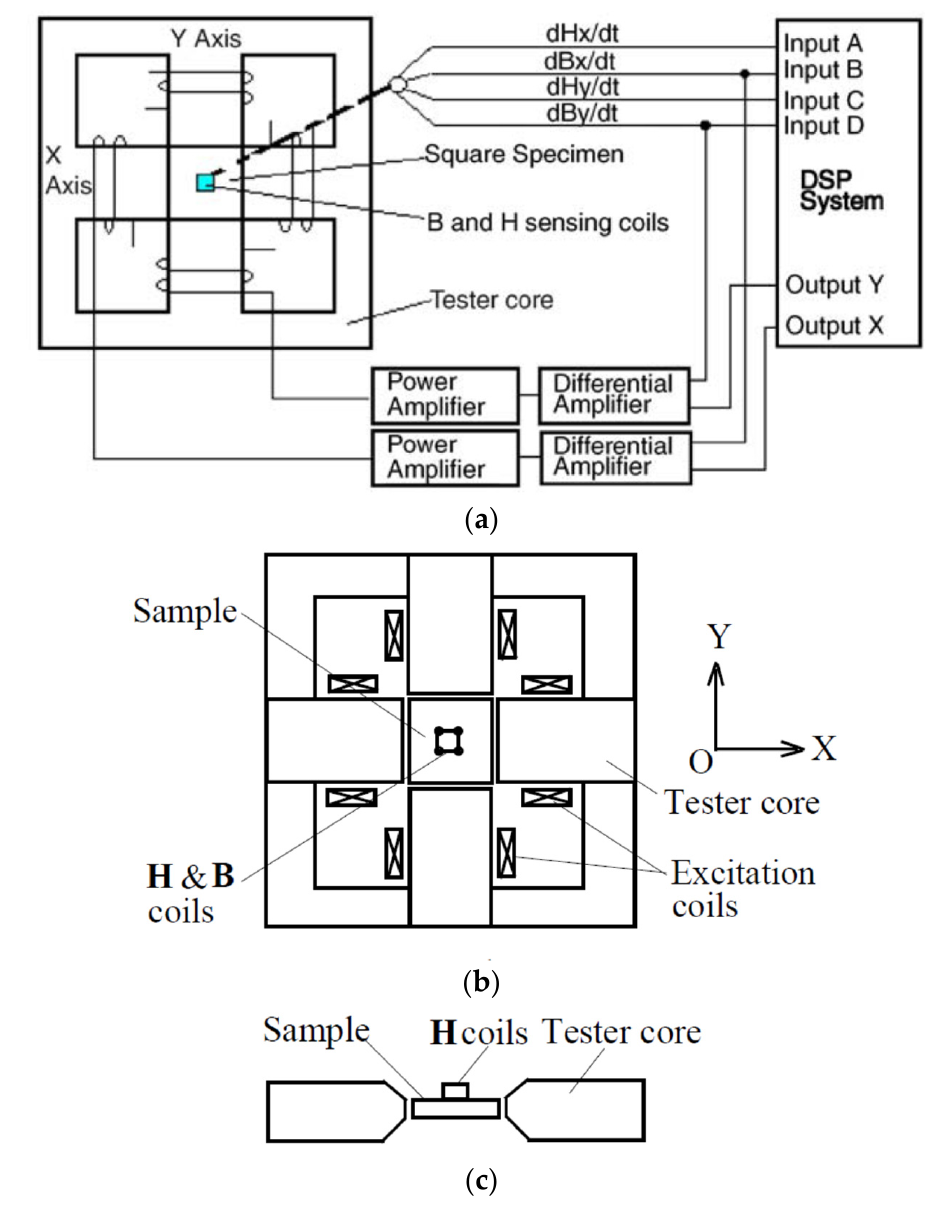
Figure 1. Principle diagram of the 2D rotating magnetic property test system: ( a ) schematic diagram, ( b ) single sheet tester for square sample and ( c ) positions of sample and H search coils.